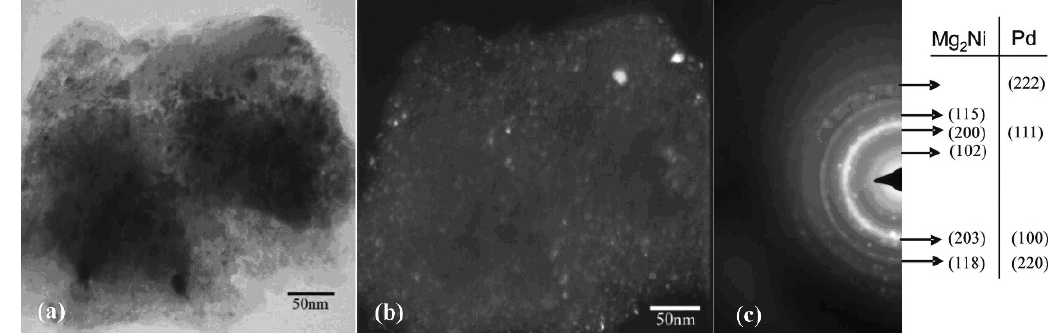
Figure 5. TEM bright field image (a), dark field image (b), and the corresponding SAEDP (c) of the Mg